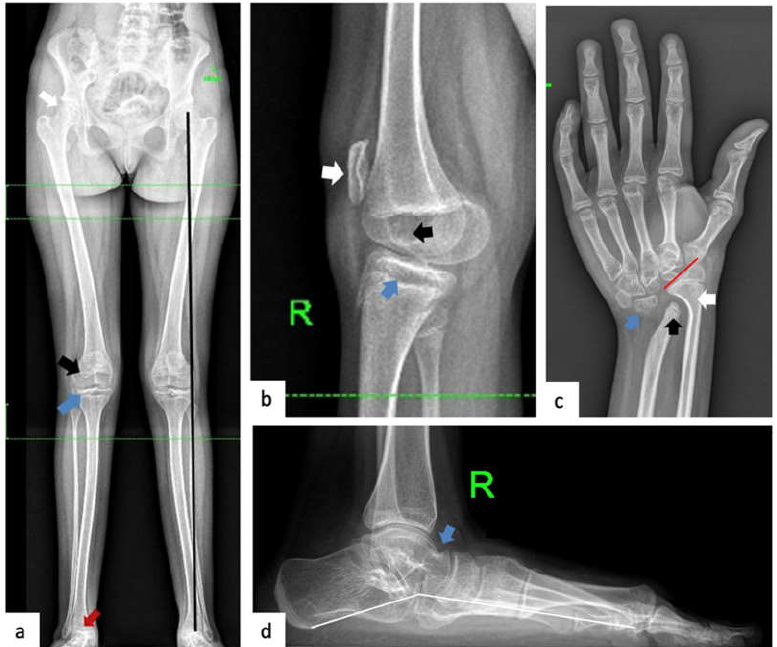
Figure 2. ( a ) Anteroposterior standing radiograph of the lower extremities: valgus deformity (lateral deviation of the mechanical axis of the lower extremities—black line); flattening and deformity of the femoral head (white arrow); flattening of the distal epiphysis of the femur and shallow intercondylar notch (black arrow); decreased height and flattening of the intercondylar eminence of the proximal tibial epiphysis (blue arrow); reduced height and wedge-shaped deformity of the distal tibial epiphysis, valgus deformity of the ankle joint (red arrow); ( b ) Lateral radiograph of the knee joint: decreased height of the distal femoral epiphysis (black arrow); decreased height of the proximal tibial epiphysis (blue arrow); high position and decreased size of the patella (patella alta) secondary to decreased height of the epiphyses (white arrow); ( c ) Anteroposterior radiograph of the wrist and hand: hypoplastic distal ulna (black arrow); deformity of the distal radius (white arrow); ulnar sloping of the articular surface of the radius (red line); dislocation of the carpal bones (blue arrow); ( d ) Lateral standing radiograph of the foot: decreased height of the foot arch (the arch angle is indicated by white lines); deformity of the talus—shortening of the neck—and deformity of the head (blue